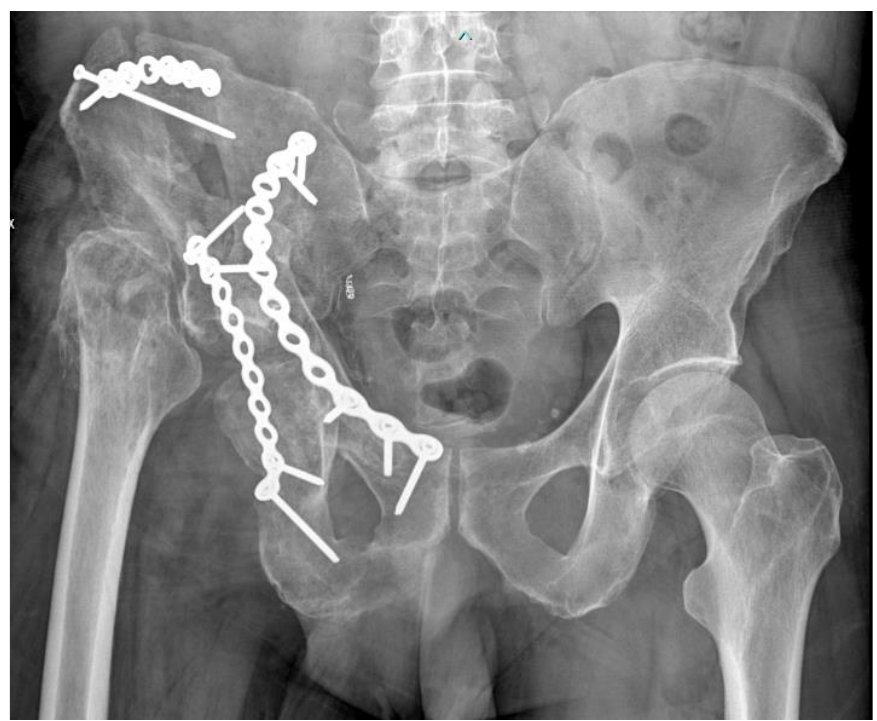
Diagnostics 2022 , 11 , x FOR PEER REVIEW Figure 4. X-ray of the pelvis after the new osteosynthesis of the bicolumnar acetabular fracture. Since we had planned to implant a total hip arthroplasty, we conducted the femoral head resection before the new osteosynthesis to perform a better debridement. At this moment, after the osteosynthesis of the posterior column, the patient suffered a cardio- genic shock: the anaesthetist forced the stoppage of the surgical procedure for the safety of the patient. The planned total hip arthroplasty was postponed. After one month, the total hip arthroplasty was performed, resuming the previous Kocher – Langenbeck ap- proach, with no complications (Figure 5).